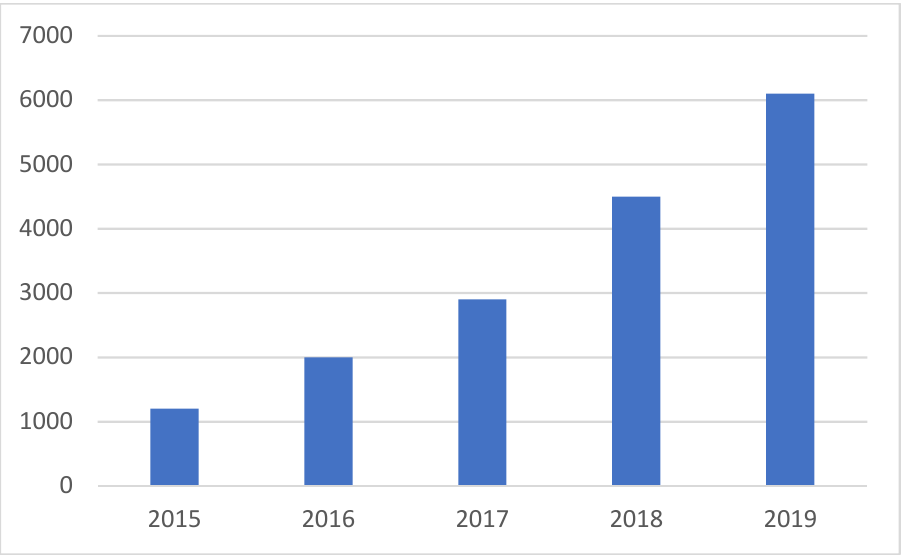
Figure 2. Changes in the scale of China’s food delivery industry from 2015 to 2019 (100 million Yuan).